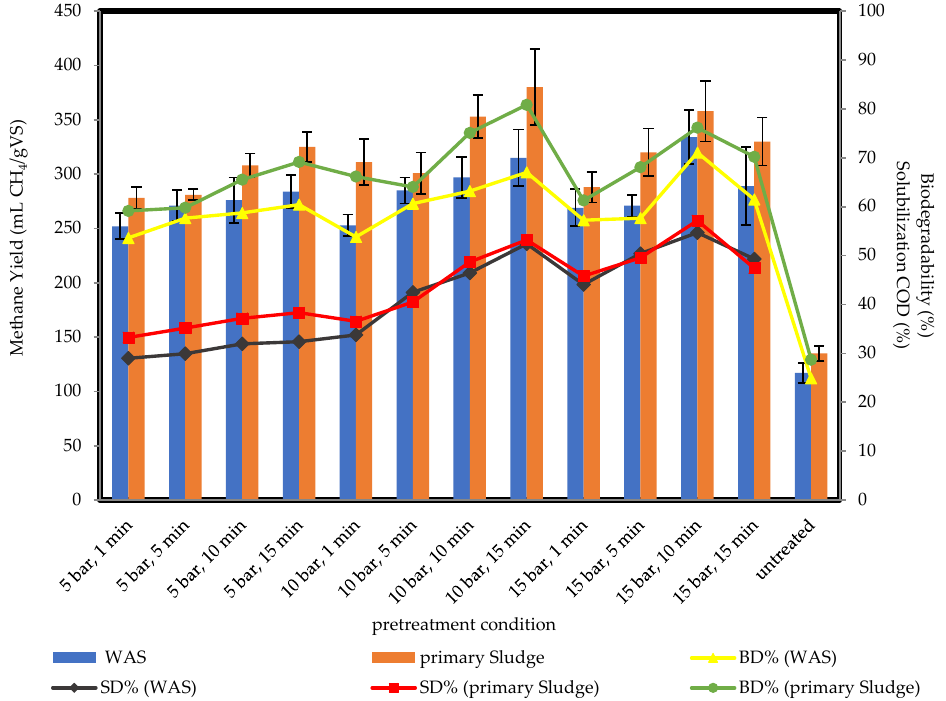
Figure 6. The relation between experimental methane yields, biodegradability, and solubilization of PS and WAS.